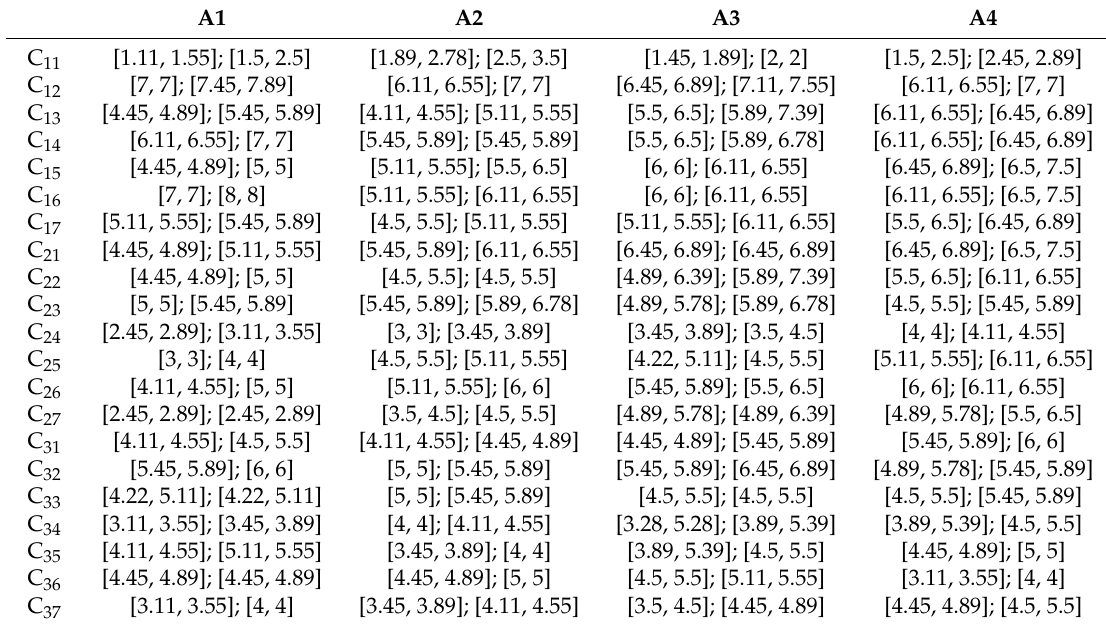
Table 3. Initial interval rough matrix.